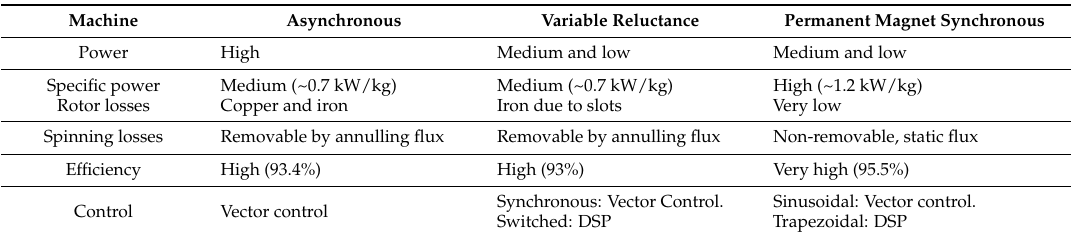
Table 1. Comparison of electrical machines suitable for use in FESS